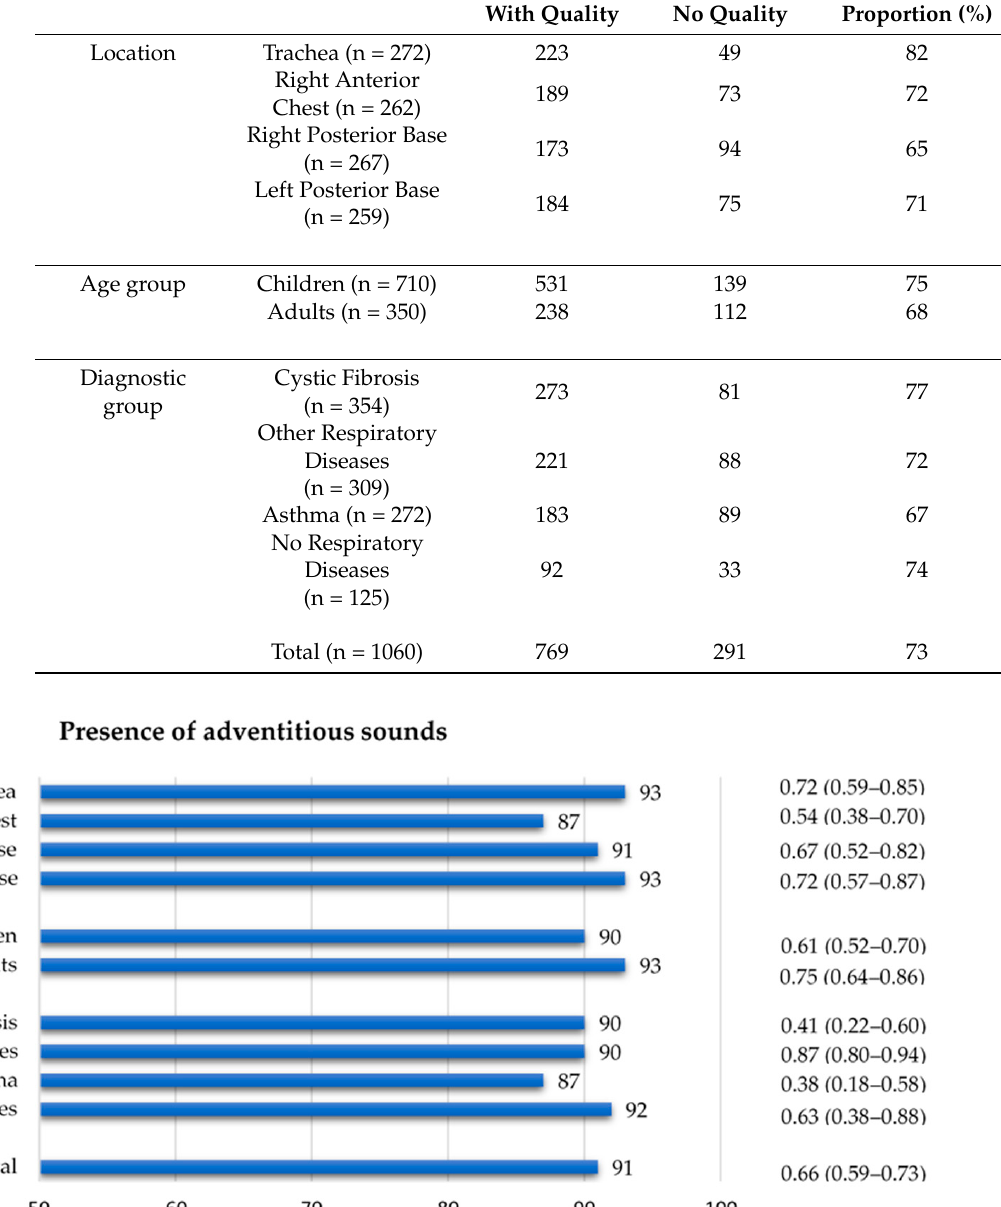
Table 2. Proportion of sounds with quality by location, age group and diagnostic group.